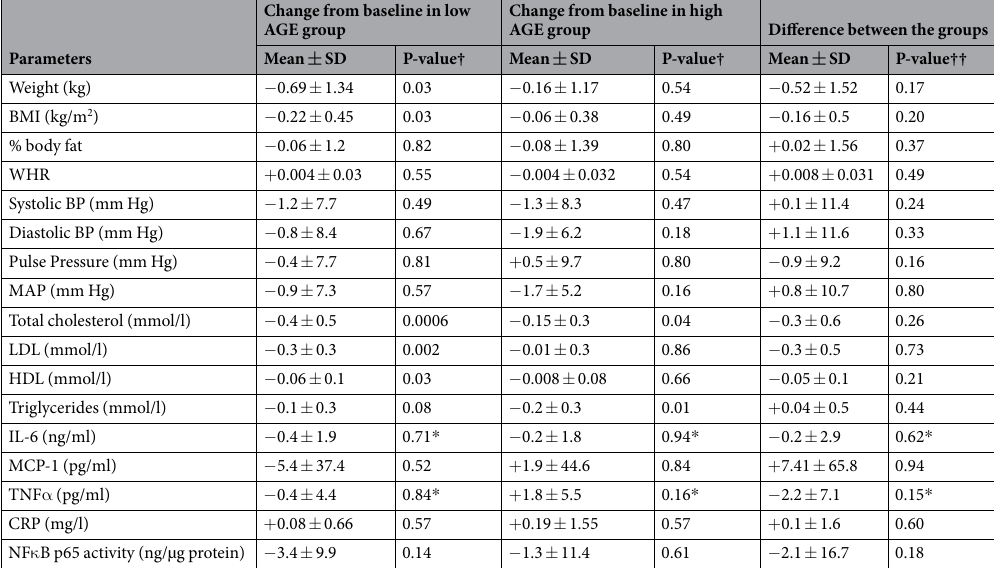
Table 2. Effects of low and high AGE diets on markers of inflammation and cardiovascular risk factors (n = 20). †Paired t-tests were conducted to determine the p-values within each groups. ††A 2 × 2 ANOVA for cross over study was used to determine the overall difference between the diets. * Data transformation was done. BP, blood pressure; CRP, C-reactive protein; HDL, high-density lipoprotein cholesterol; IL-6, interleukin -6; LDL, low- density lipoprotein; MAP, mean arterial pressure; MCP-1, monocyte chemoattractant protein-1; NF κβ ; nuclear factor kappa B; SD, standard